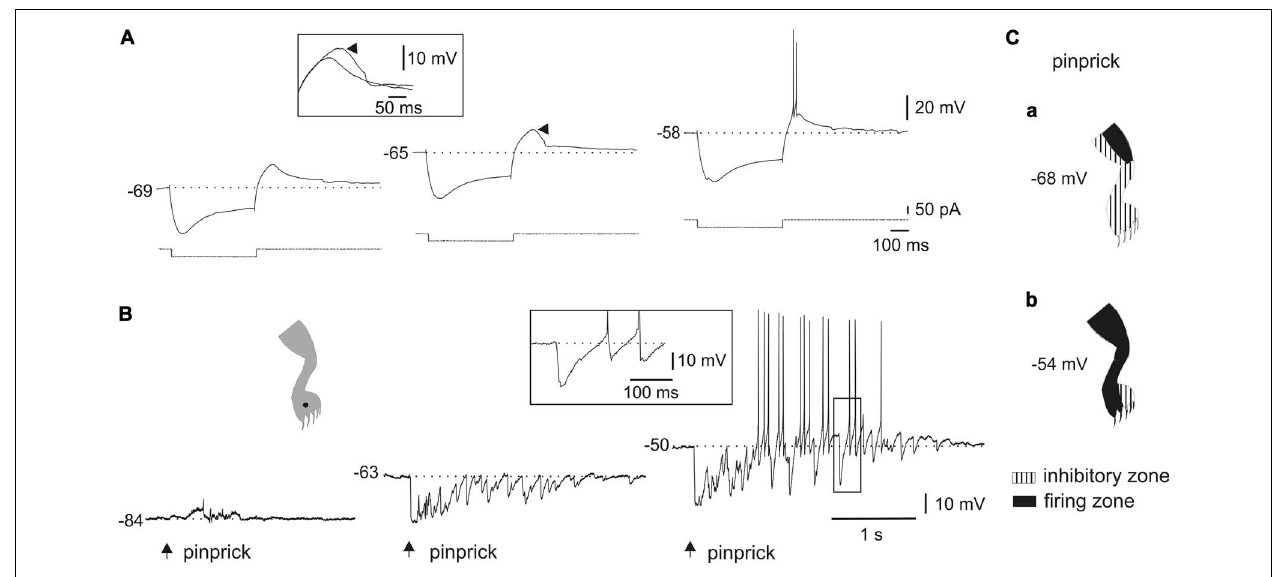
FIGURE 2 | Interaction between the LTS and synaptic activity elicited by natural stimulation. (A) A hyperpolarizing current pulse applied at different levels of bias current. Notice that the rebound response grew as the membrane potential was depolarized to generate a burst of action potentials ( − 58 mV).The inset shows the superimposed rebounds generated at − 69 and − 65 mV (arrowhead). (B) In the cell shown in (A) , a barrage of IPSPs was generated when pinprick was applied to a spot within the receptive field (dot